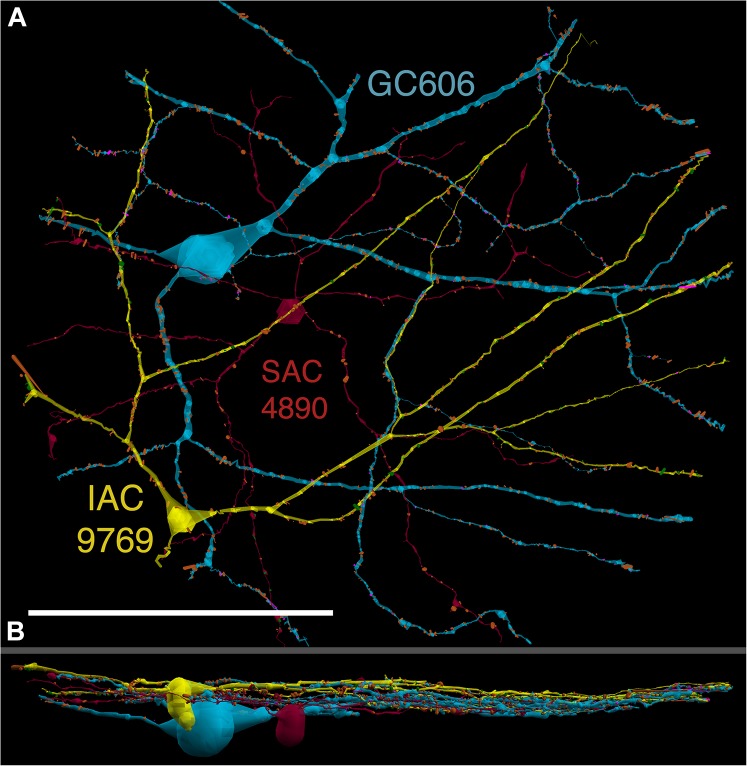
(A) XY projection of commingled GC 606 (light blue) and IAC 9769 (yellow) dendritic arbors just distal to the dendrites of starburst amacrine cell (SAC) 4890 (red) in the inner plexiform layer of connectome RC1. Computer generated three dimensional rendering of Viking annotations generated with VikingPlot. Small dots indicate the relative sizes (scaled by a factor of 2 for visualization) and locations of presynaptic specializations (green), PSDs (orange), gap junctions (magenta). (B) XZ projection demonstrating lamination of GC 606, SAC 4890, and IAC 9769. Scale, 100 μm.